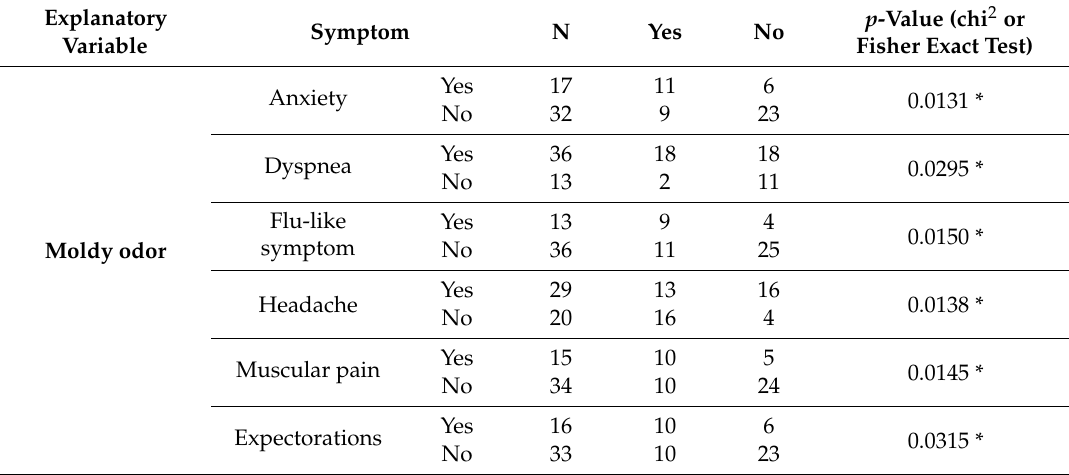
Table 8. Moldy odor as explanatory variable of the symptoms mentioned by inhabitants. Explanatory Variable